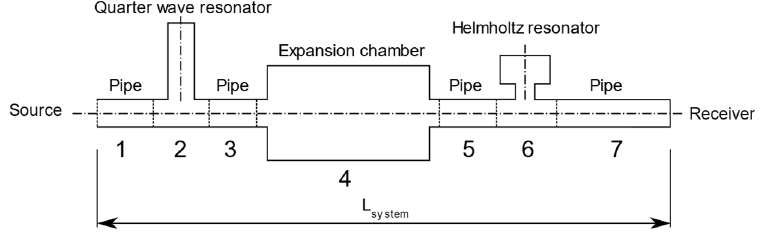
Figure 10. Example of cascade-coupled silencer system with three silencer